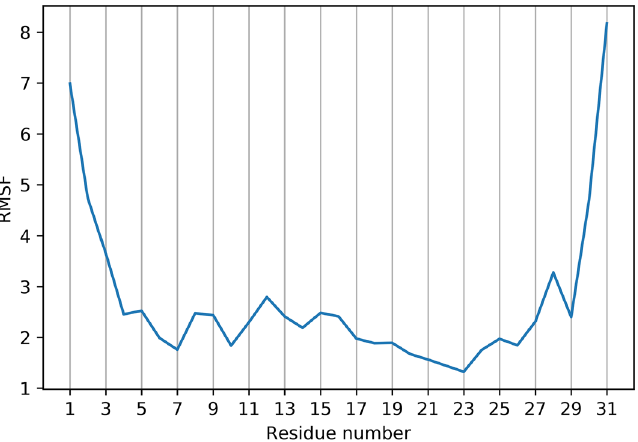
Figure 8. Root-mean-square fluctuation (RMSF) calculated for the backbone atoms of each residue of palustrin-Ca over the course of the simulation. It is apparent that the peptide structure is generally rigid, with the exception of the N- and C-terminal residues, which are relatively